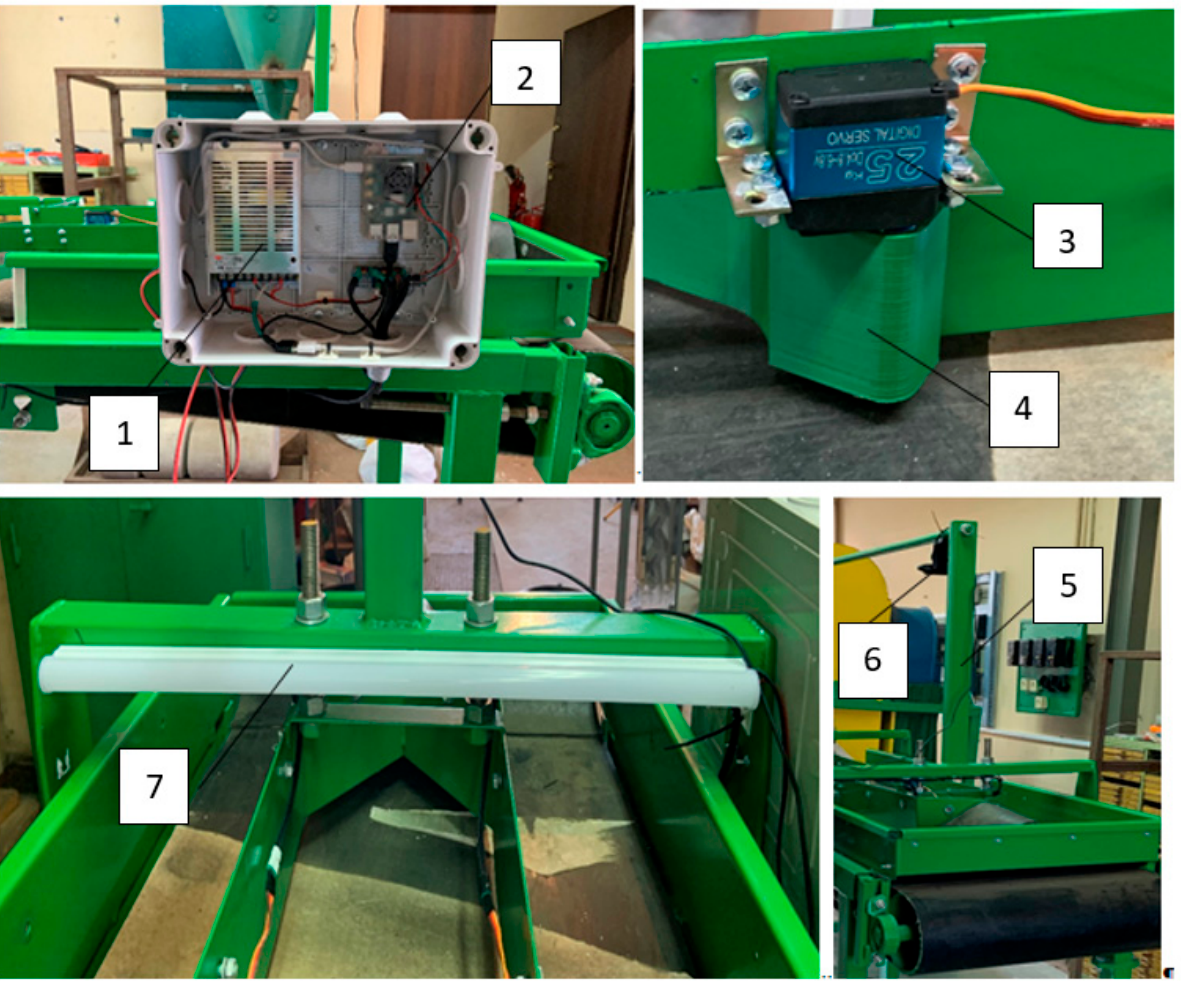
Figure 9. Software and hardware of the automatic line control system for the post-harvest processing of root and tuber crops and onions: 1—microcontroller “Arduino Mega 2560”; 2—power supply unit; 3—servo drive “SG90”; 4—actuator; 5—camera mounting bracket; 6—“Logitech HD Pro C920” webcam; 7—DNaT-400 high pressure gas discharge lamp.